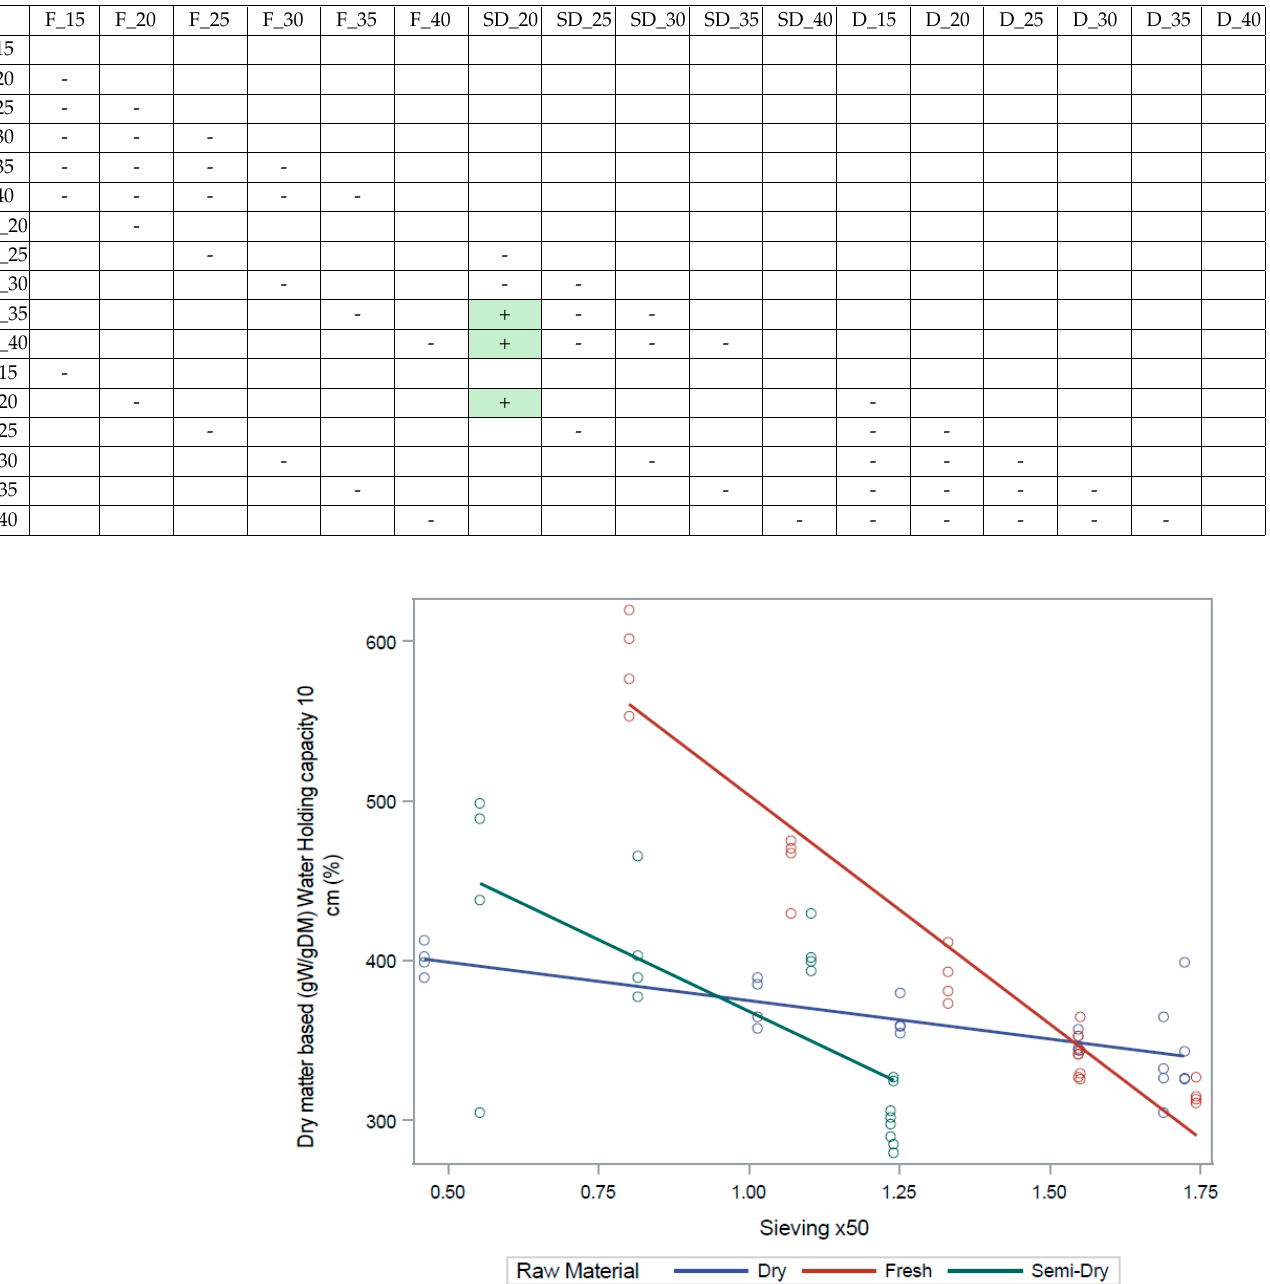
Figure A2. Correlation between WHC − 5 kPa (dry matter based) and X-50.